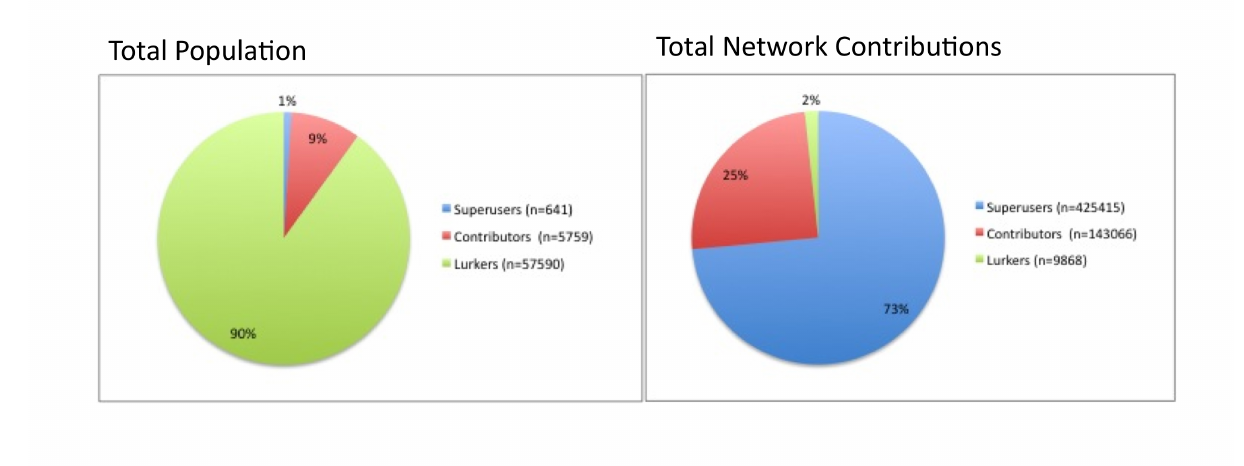
Figure 2. Cumulative DHSN population distribution and content creation according to the 1%